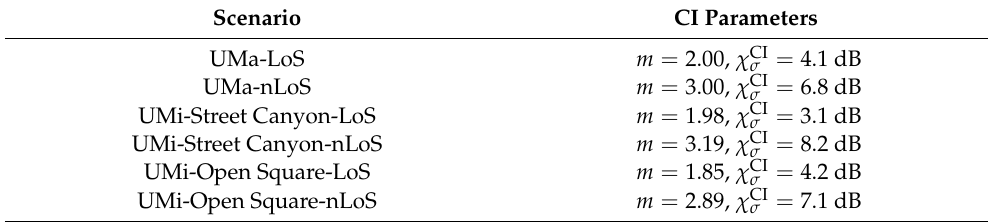
Figure 2. Channel matrix H ∈ C K × N is constructed by finding the complex channel coefficients between each antenna and each user, for N antennas and K users. Table 1. CI path loss model parameters for different Urban Macro (UMa), Urban Micro (UMi), line of sight (LoS) and non line of sight (nLoS) scenarios